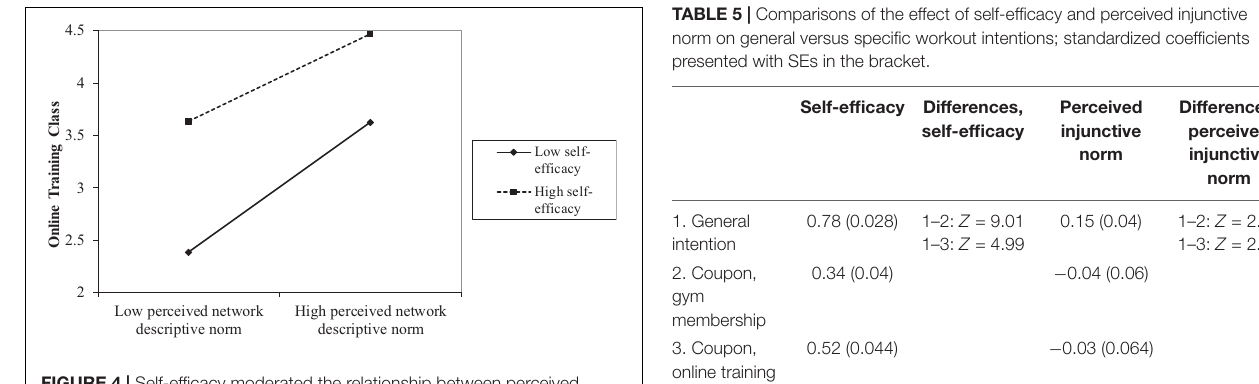
FIGURE 4 | Self-efficacy moderated the relationship between perceived descriptive norm of workout and the intention to purchase the coupon for online training classes.